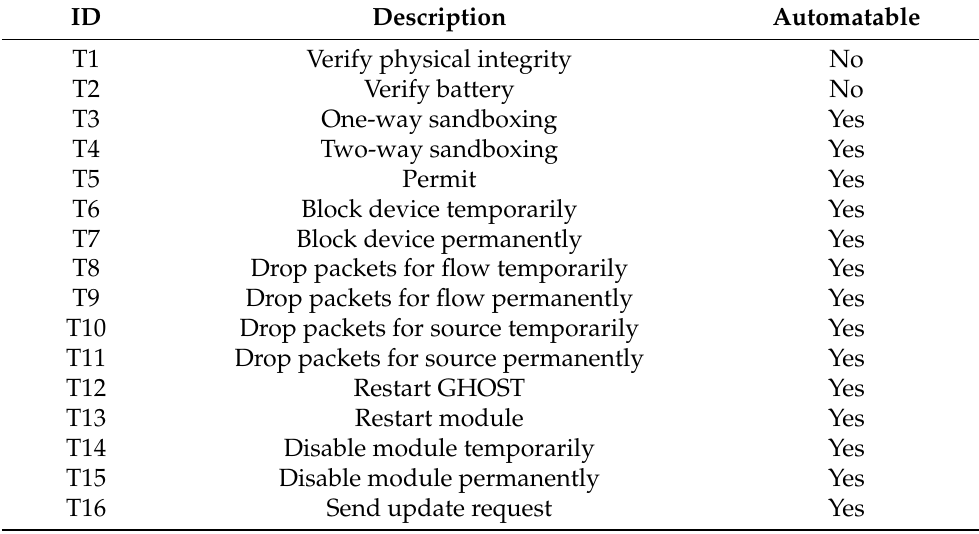
Table 2. Technical actions for